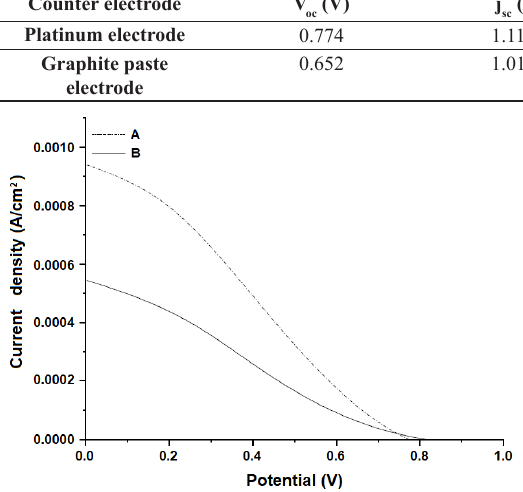
Figure 3. j x V curves of cells with two different forms of graphite deposition from graphite paste (A) and pencil (B), both sintered at 723 K. Other conditions: electrolyte: tetrabutylammonium iodide (0.05M) / I (0.005M); substrate: FTO; Photoanode: TiO 2